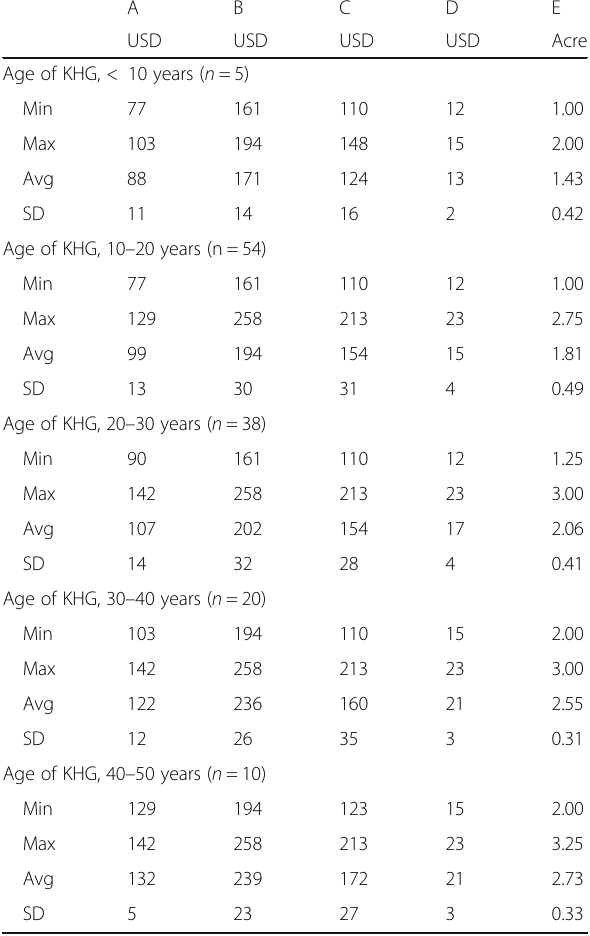
Table 1 Summary of the monthly economic status of the household in Aranayaka landslide area. Data obtained from a structuredquestionnaire